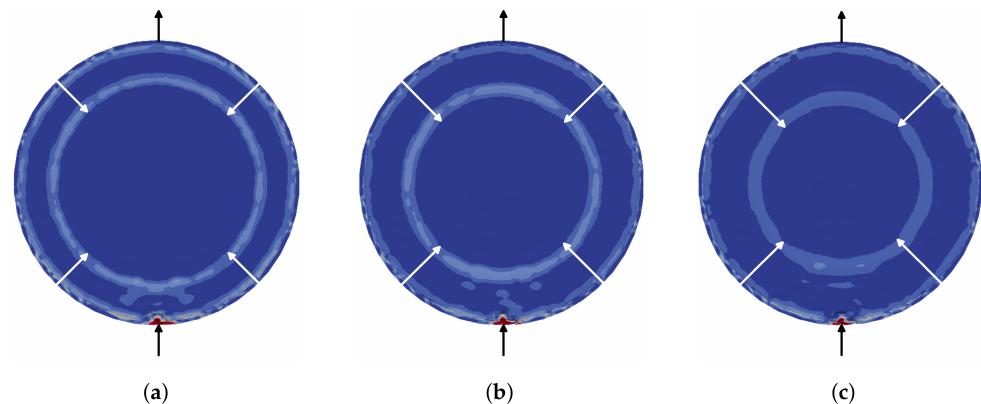
Figure 6. Wave propagation at different time steps from the beginning of the flow: ( a ) t 1 = 0.50 s; ( b ) t 2 = 0.60 s; and ( c ) t 3 = 0.70 s.